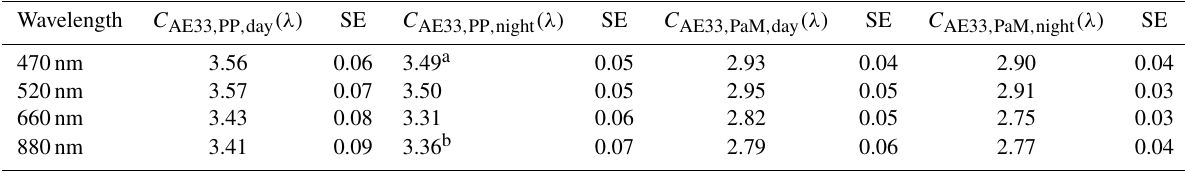
Table 3. Multiple-scattering enhancement parameter and standard error (SE) for AE33 at different wavelengths calculated separately for the day and night datasets using PP ( C AE33_PP_day and C AE33_PP_night , respectively) and PaM ( C AE33_PaM_day and C AE33_PaM_night , respectively)